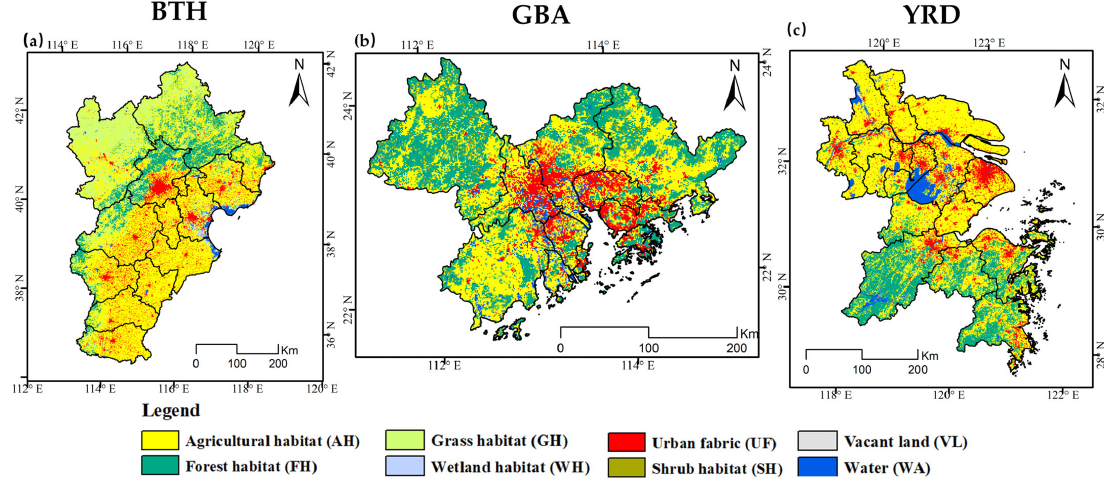
Figure 4. Thematic maps of land cover/use for three UAs: ( a ) BTH, ( b ) GBA, and ( c ) YRD.